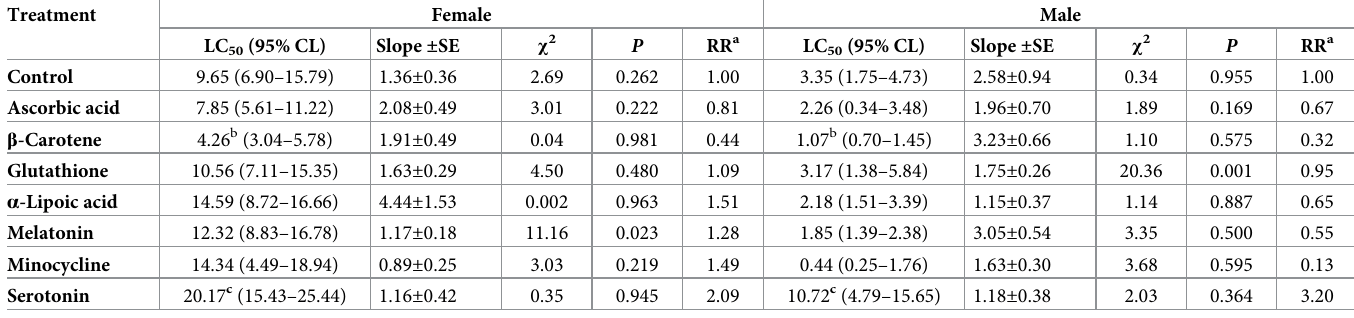
Table 3. LC 50 ( μ g/vial DDT) values with 95% confidence limits (CL), slope, χ 2 , and resistance ratio (RR) for D . melanogaster 91-C adult females and males fed on the indicated antioxidants. Treatment